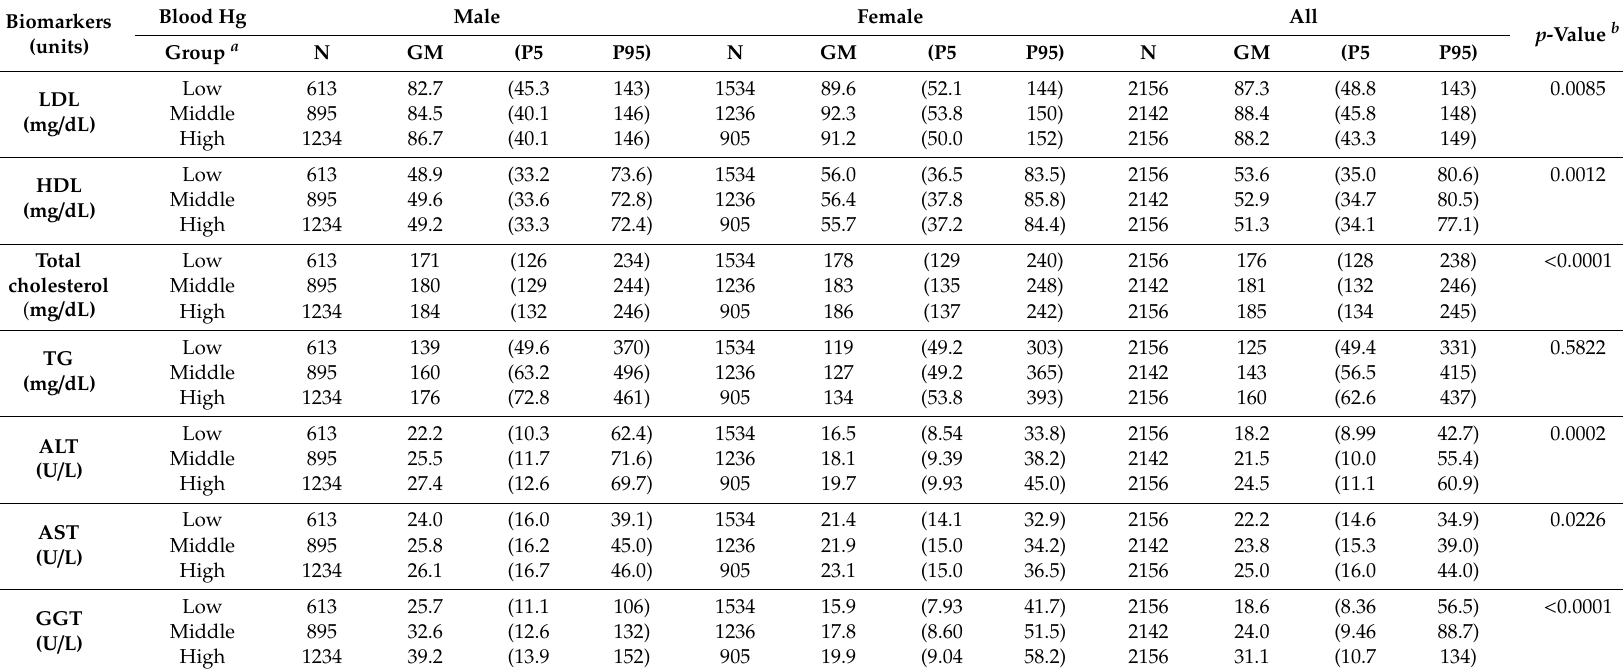
Table 2. Lipid profiles and hepatic enzymes among the blood Hg